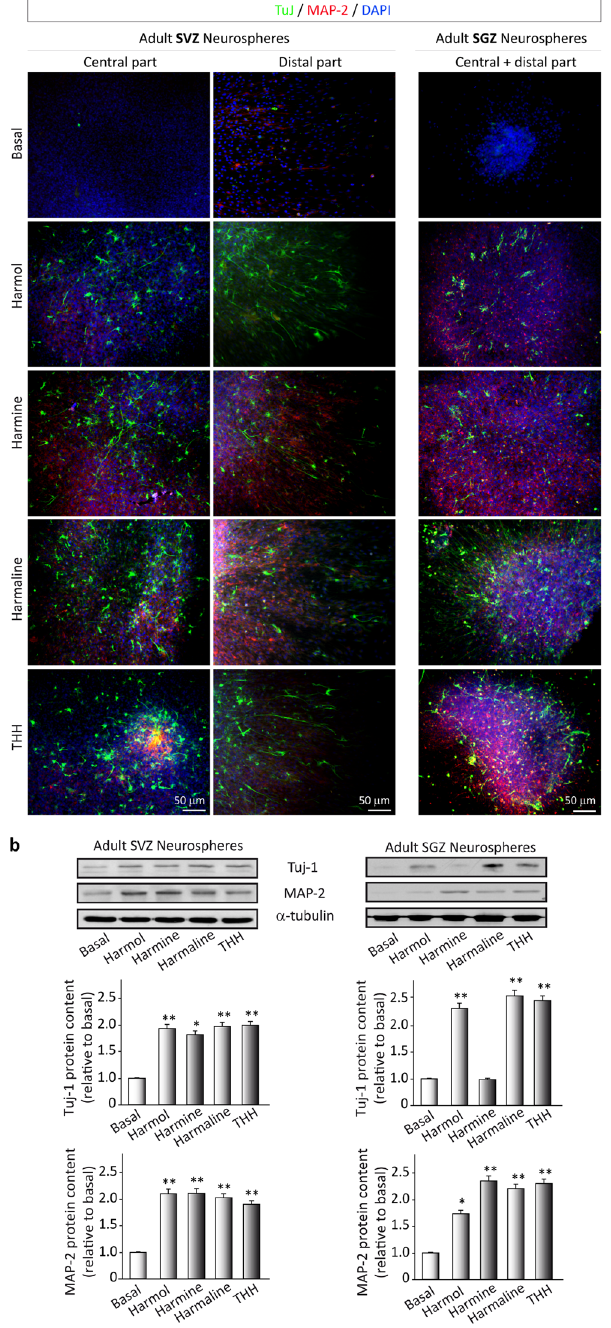
Figure 4. Ayahuasca β -carboline alkaloids promote stem cell differentiation towards a neuronal phenotype. After 7 days on culture in the presence of harmol, harmine, harmaline and tetrahydroharmine (THH), free floating neurospheres derived from the adult subgranular (SGZ) and subventricular (SVZ) zone were adhered on coated coverslips and allowed to differentiate for 3 days in the presence of alkaloids at 1 µ M. ( a ) Representative immunofluorescence images showing the expression of the neuronal markers β -III-Tubulin (TuJ-1 clone, green) and MAP-2 (red) in neurospheres. DAPI was used for nuclear staining. SVZ-derived neurospheres are shown in two panels showing the central part of the sphere (left) and the distal migration site (right). Single images from SGZ-derived neurospheres show the whole neurosphere, including the central and distal areas. Scale bar = 50 μ m. ( b ) Representative Western blots of β -tubulin and MAP-2. Quantification analyses are also shown. Results are the mean ± SD of the quantification of at least three independent experiments corresponding to four different cellular pools. The left side of the image shows results for the subventricular zone (SVZ) of the brain. The right side of the image shows results for he subgranular zone of the hippocampus (SGZ). * p ≤ 0.05; ** p ≤ 0.01 indicate significant results in the post-hoc pair-wise comparisons (Bonferroni) versus non-treated (basal)